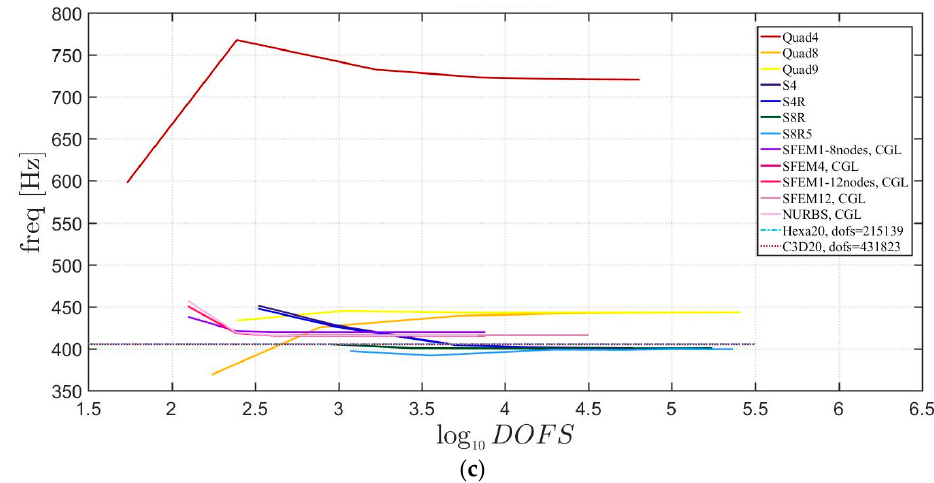
Figure 18. First three natural frequencies of a circular plate with a symmetric lamination scheme and a / h = 10: ( a ) First frequency; ( b ) Second frequency; ( c ) Third frequency.